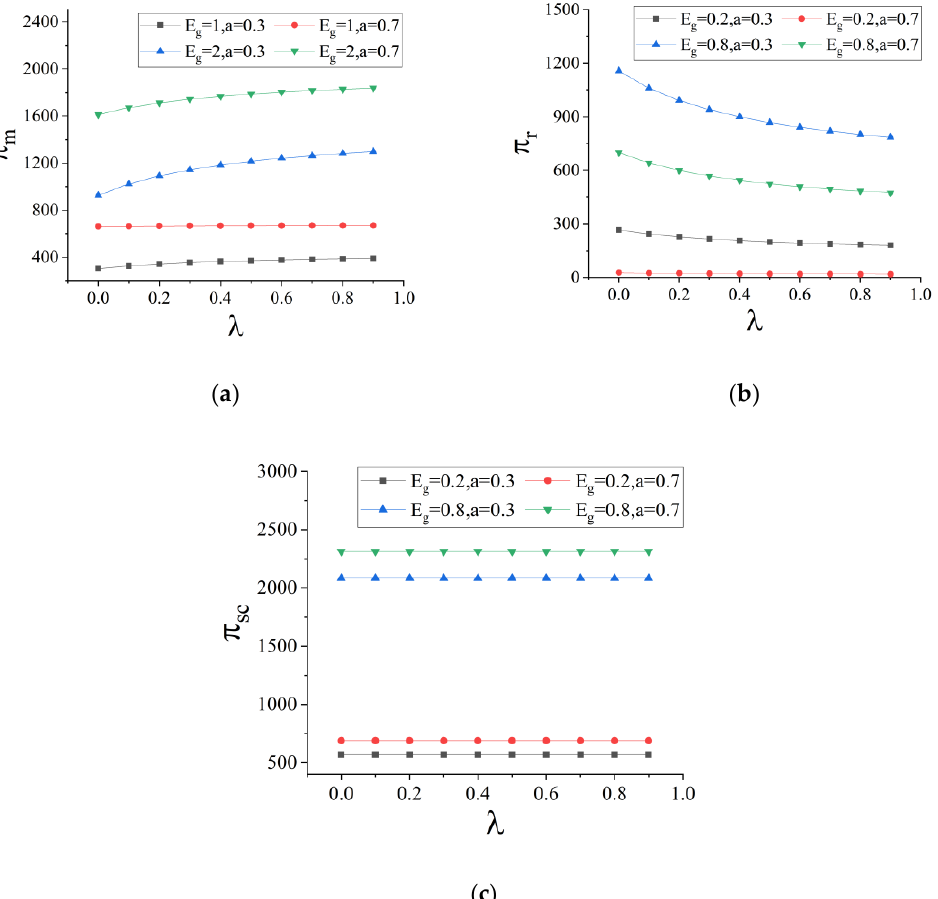
Figure 4. The impact of fairness concerns of manufacturer on the profits of manufacturer, retailer and supply chain. ( a ) The impact of fairness concerns of manufacturer on the profits of manufac- turer; ( b ) The impact of fairness concerns of manufacturer on the profits of retailer; ( c ) The impact of fairness concerns of manufacturer on the profits of supply